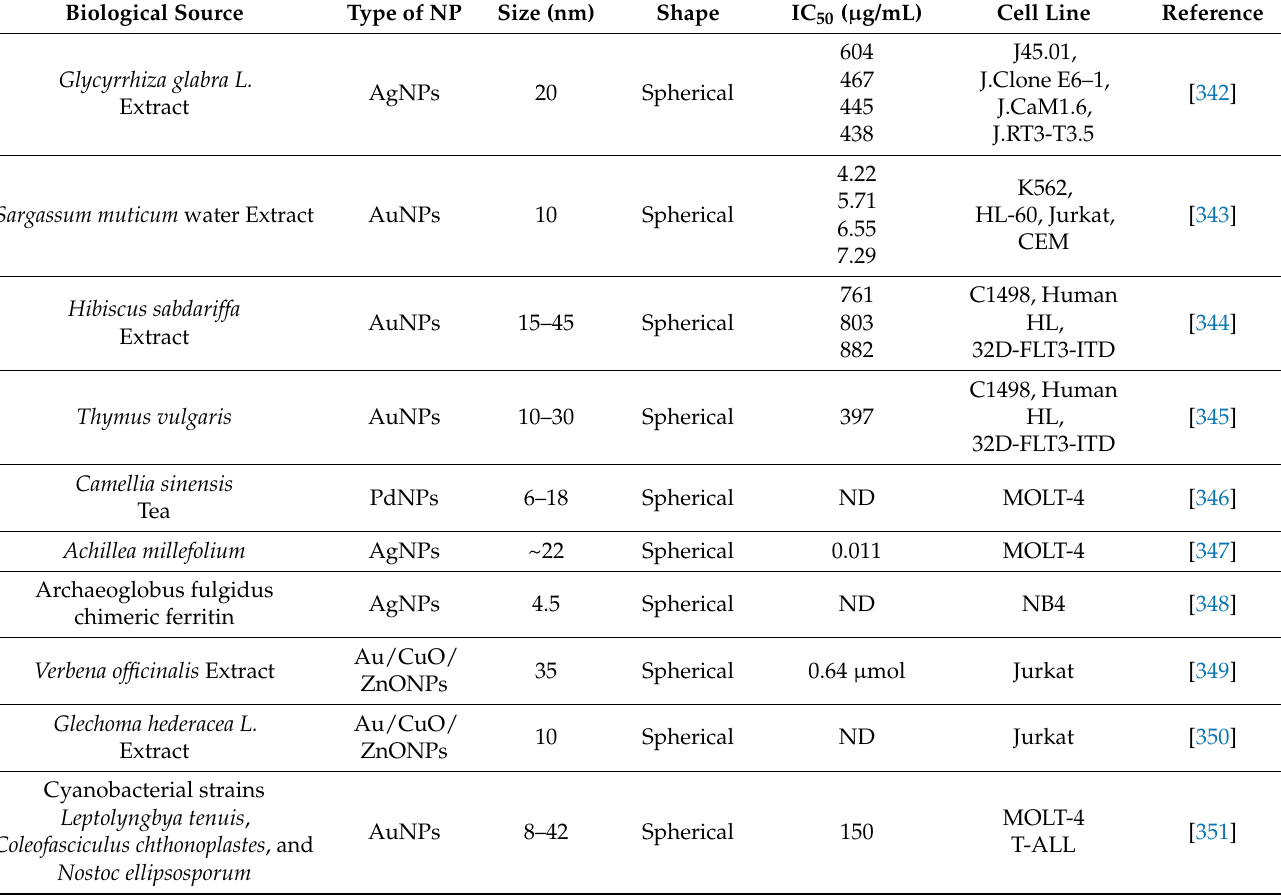
Table 11. Evaluation of green biogenic Au and AgNPs in leukemia cells; biological source, NPs characteristics, IC 50 , and in vitro